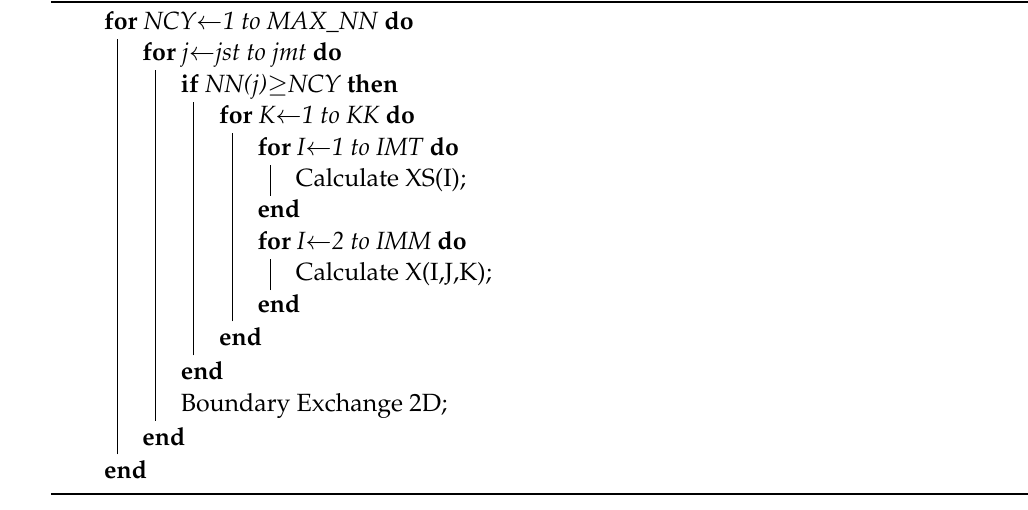
Algorithm 3: Communication Optimization (I-B)